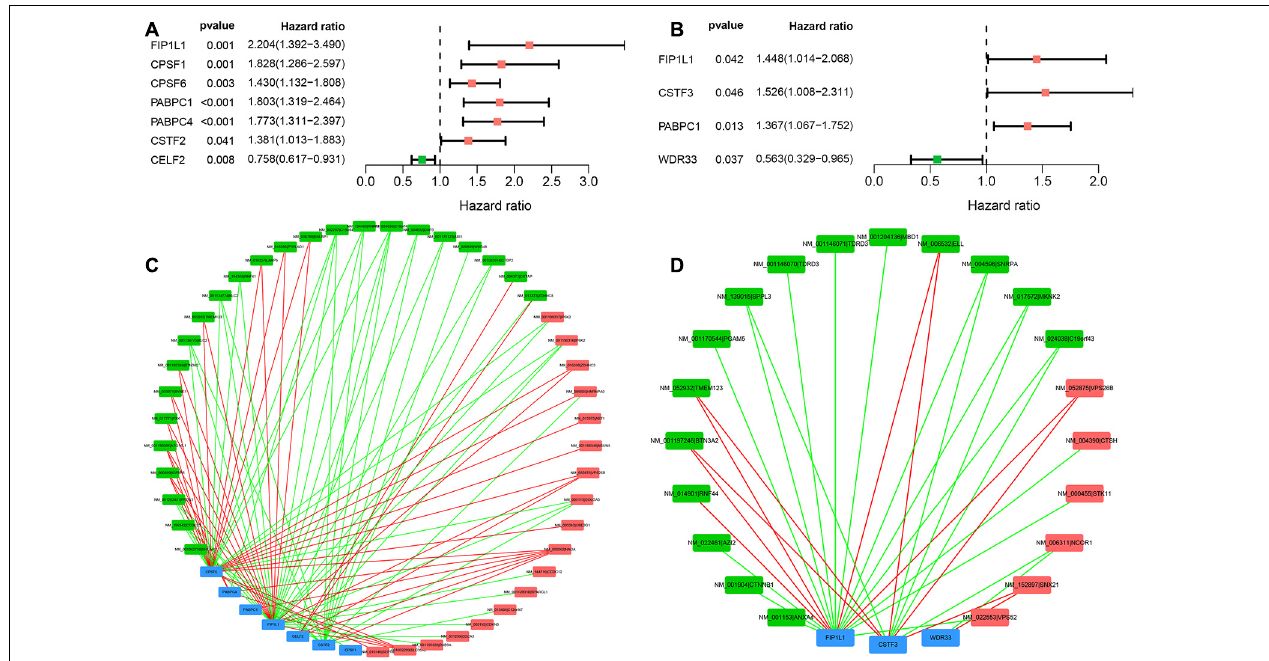
FIGURE 7 | Survival-associated APA factors and APA events correlation network in sarcoma. (A) Seven OS-related APA factors identified by univariate Cox analysis. (B) Four PFS-related APA factors identified by univariate Cox analysis. (C) Regulatory network of OS-related APA factors and APA events. Blue rectangles means APA factors, green rectangles means protective APA events, and red rectangles means risk APA events. Green line means negative correlation between the PDUI of APA events and the expression of APA factors. (D) Regulatory network of PFS-related APA factors and APA events. Blue rectangles means APA factors, green rectangles means protective APA events, and red rectangles means risk APA events. Green line means negative correlation between the PDUI of APA events and the expression of APA factors. APA, alternative polyadenylation; OS, overall survival; PFS, progress